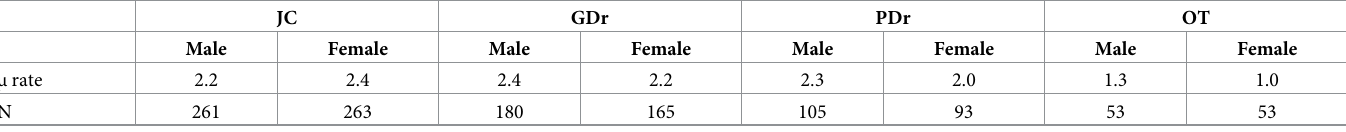
Table 1. Mean number of visits to healthcare providers for a single episode of fever, by